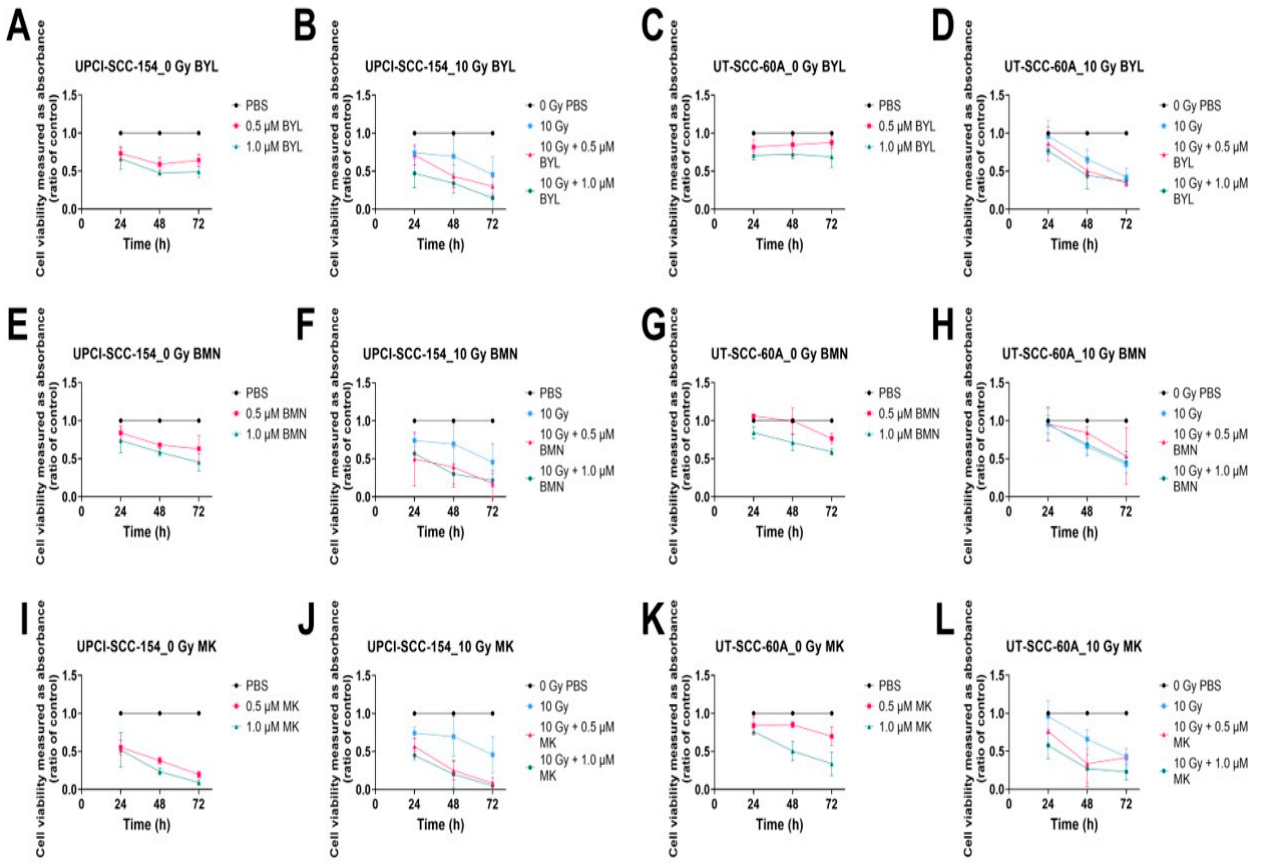
Figure 1. WST-1 viability assays on HPV + UPCI-SCC-154 and HPV − UT-SCC-60A with viability measured as absorbance 24–72 h after single treatments with 0.5–1 µ M BYL719 ( A – D ), BMN-673 ( E – H ), and MK-1775 ( I – L ), with/without 10 Gy. BYL denotes BYL719, BMN denotes BMN-673, and MK denotes